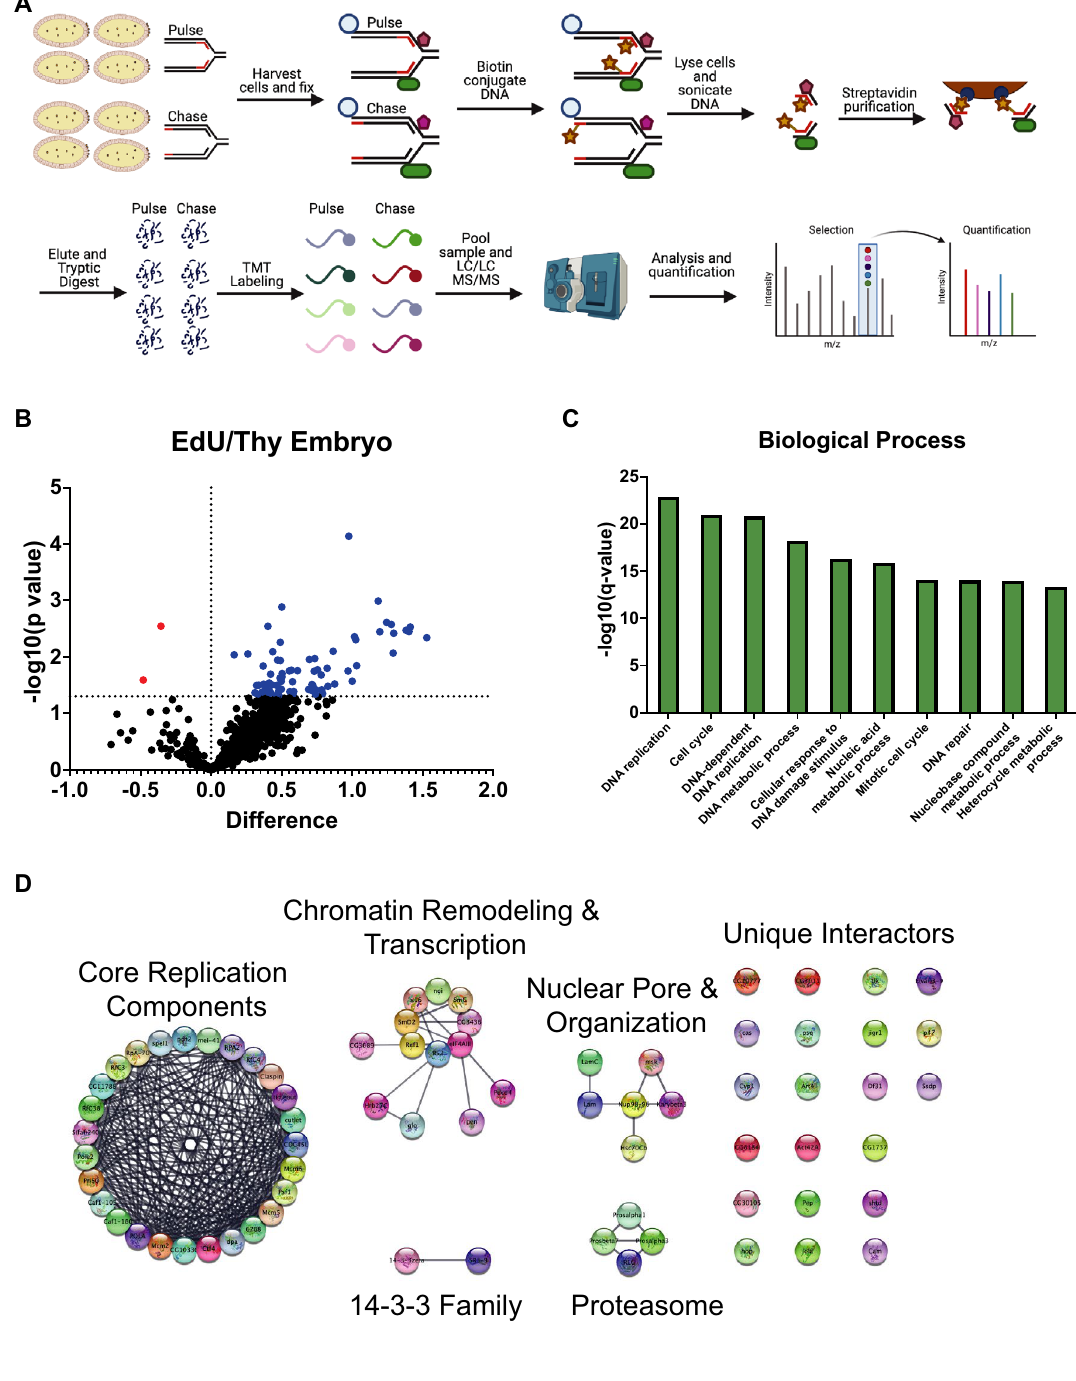
Figure 2. iPOND coupled to quantitative mass spectrometry in the post-MZT embryos. ( A ) A schematic of the labeling and mass spectrometry process for iPOND-TMT in Drosophila post-MZT embryos. ( B ) Volcano plot visualizing proteins identified as enriched or depleted in the pulse versus the chase embryo samples. Enrichment on the X-axis (log2[pulse]-log 2 [chase]) and − log 10 (p-value) on the Y-axis. ( C ) The top 10 enriched biological processes of the proteins enriched in the pulse sample as determined by Gene Ontology (GO) analysis. ( D ) Network map of the proteins enriched in the pulse sample, clustered into groups of known interactors using the STRING database with no additional interactors